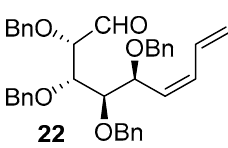
Figure 5. The structure of diene 19 .